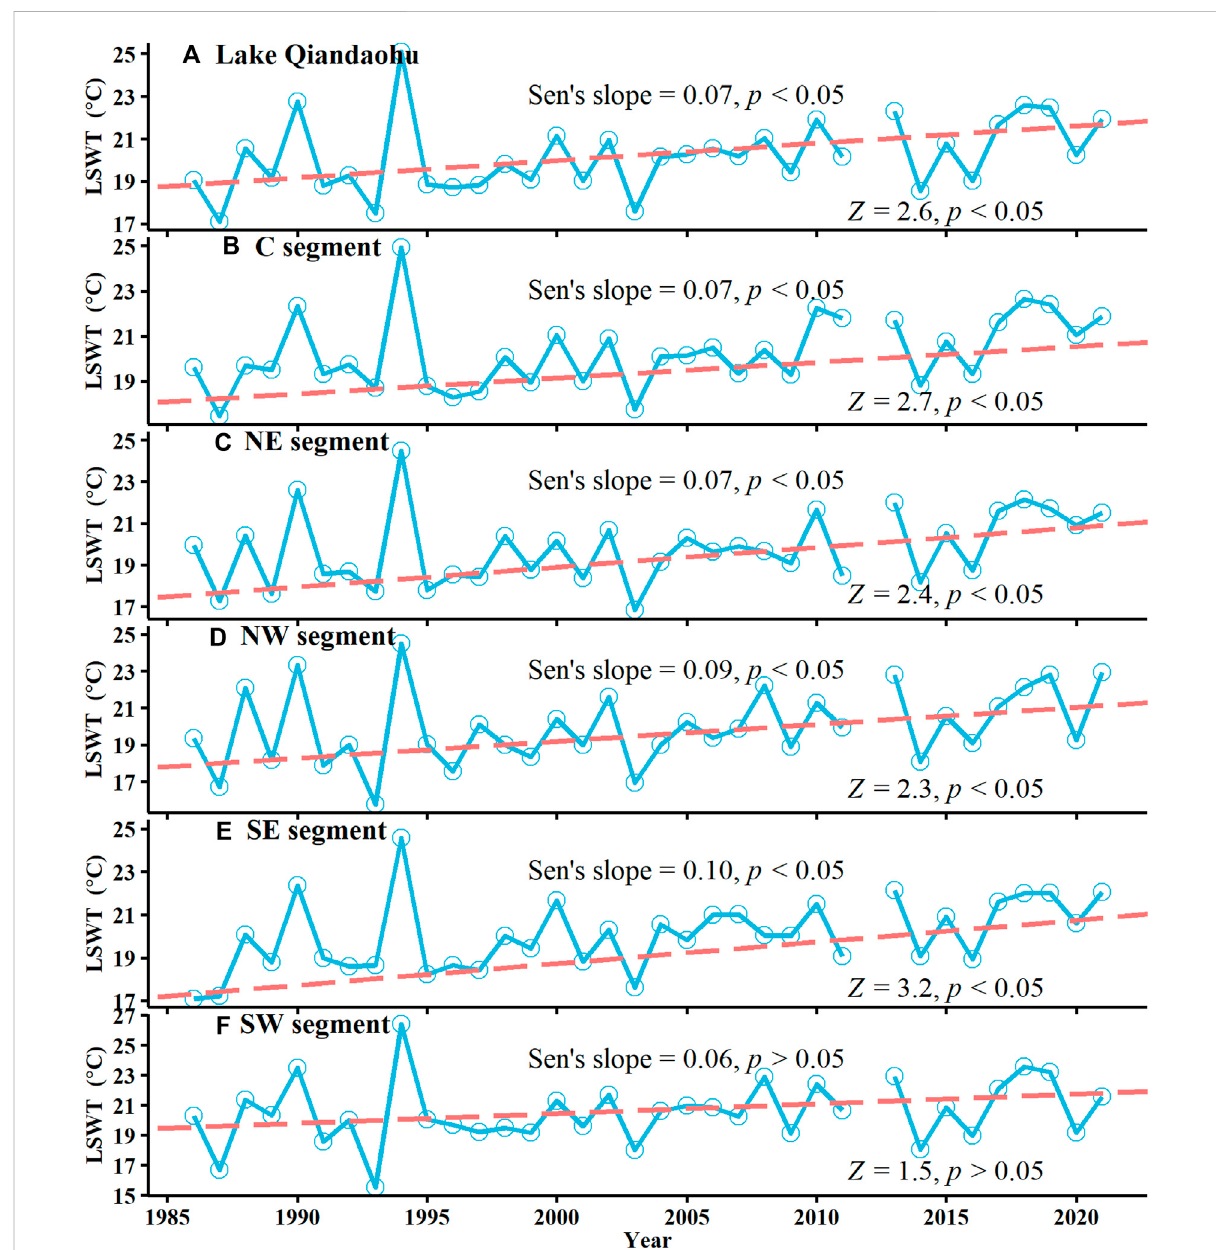
FIGURE 6 Long-term LSWT trends in Lake Qiandaohu (A) , the C segment (B) , NE segment (C) , NW segment (D) , SE segment (E) and SW segment (F)